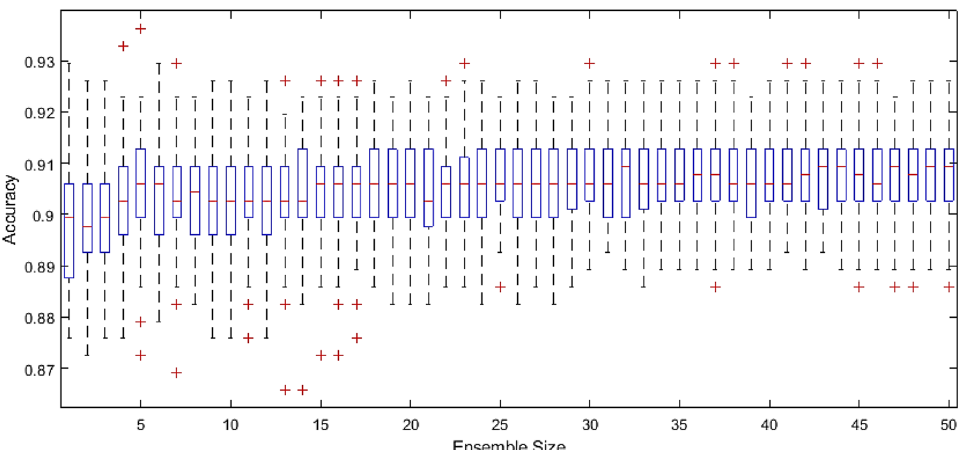
Figure 4. Generalization ability of the proposed model (complete CIC) based on the boosted trees ensemble versus the ensemble size. the boxplots are based on Monte Carlo simulations of complete re-runs of the models, not just error-scatters of testing set of an individual simulation. In each simulation, the CI stages are configured based on the critical feasibility set size, latent space size and missing information